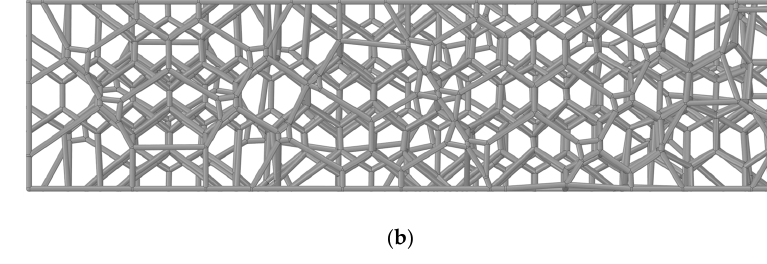
Figure 1. Generated VF : ( a ) Front view; ( b ) Right view.